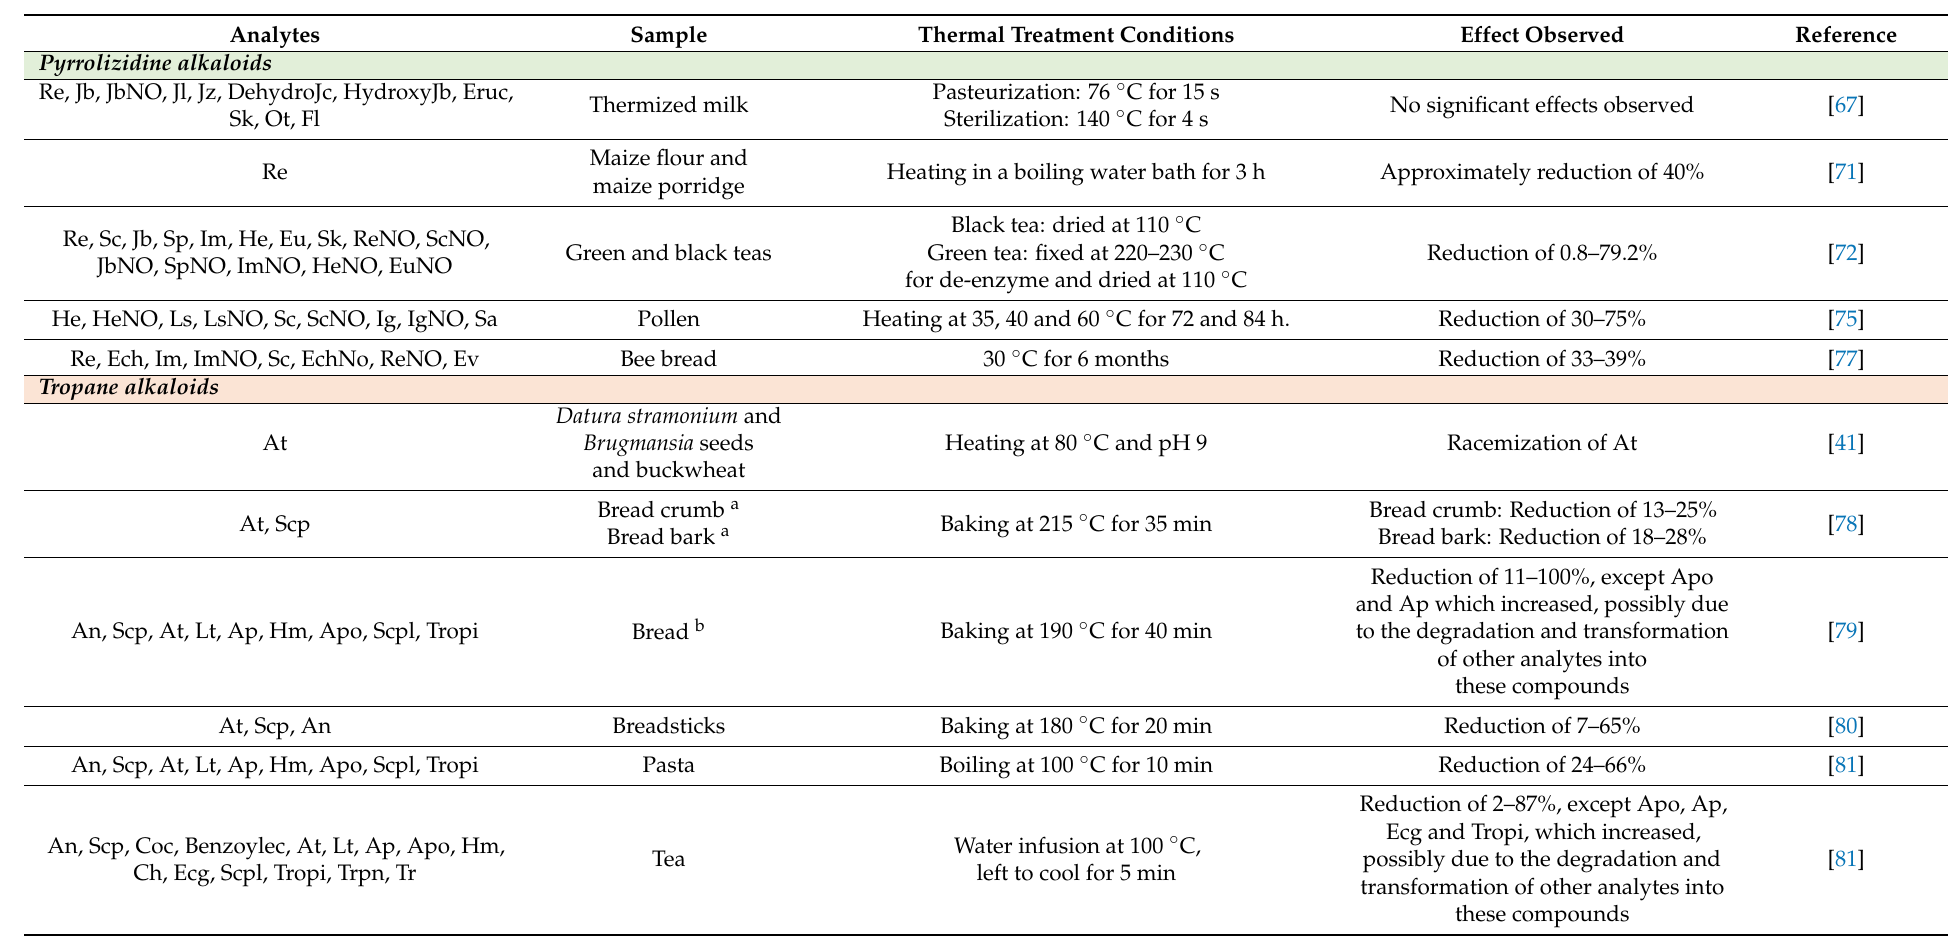
Table 1. Thermal treatment effects on the contents of pyrrolizidine, tropane and opium alkaloids in food samples according to literature